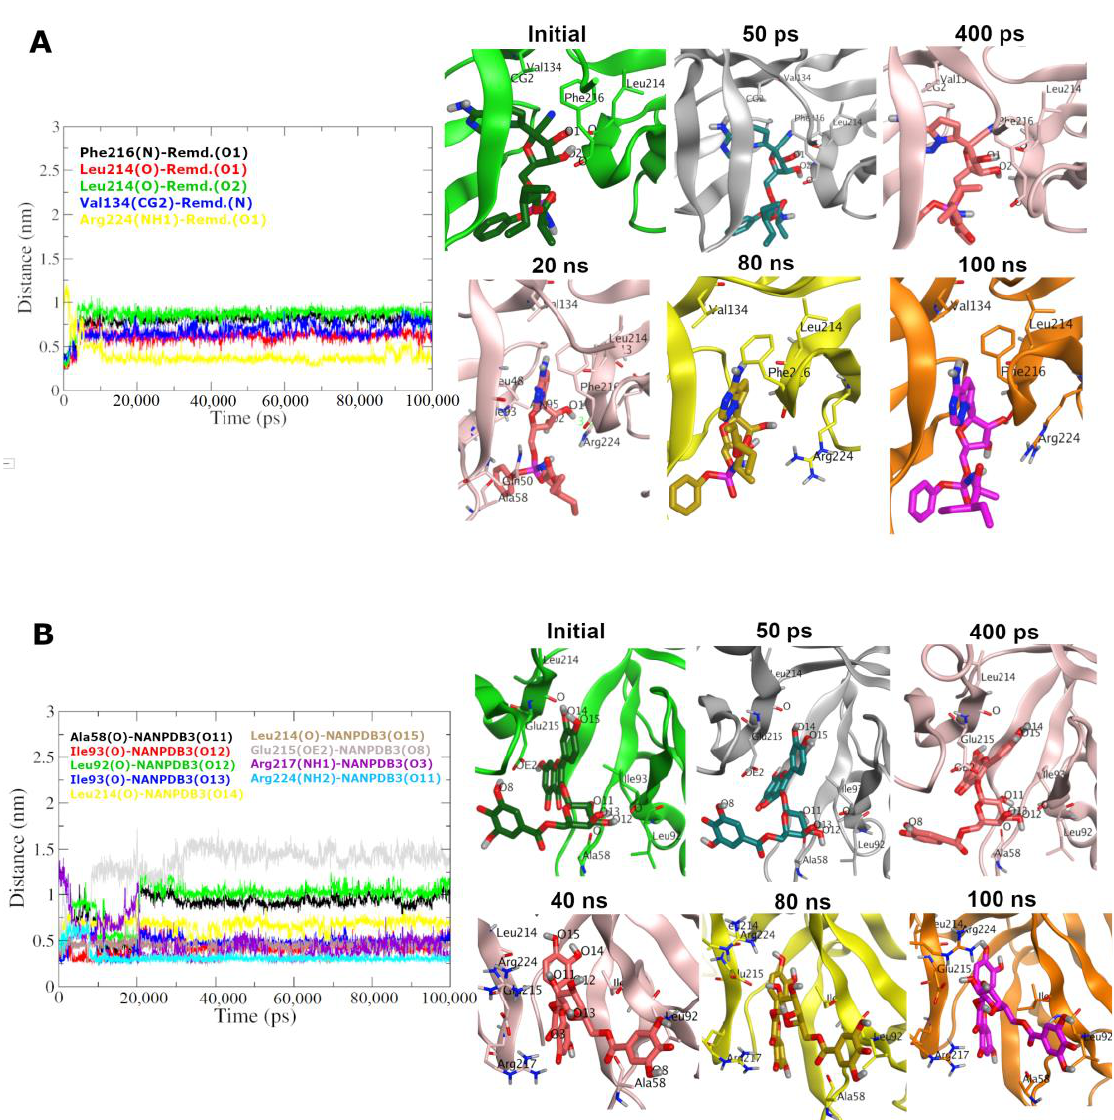
Figure 10. The minimum distance graph of both Remdesivir- and NANPDB3- Fascin interactions for ( A ) and ( B ), respectively, during the MD simulation. Snapshots at different simulation time are illustrated for both systems.